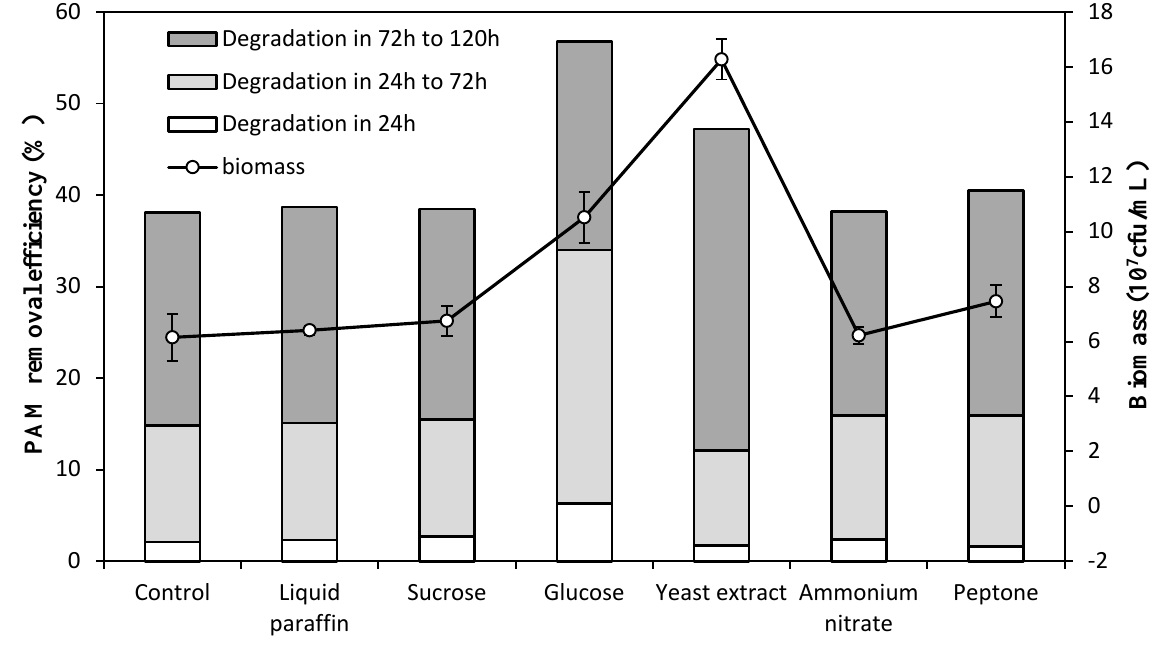
Figure 4. Effect of exogenous nutrients on PAM removal efficiency and viable cell biomass in 5 days of